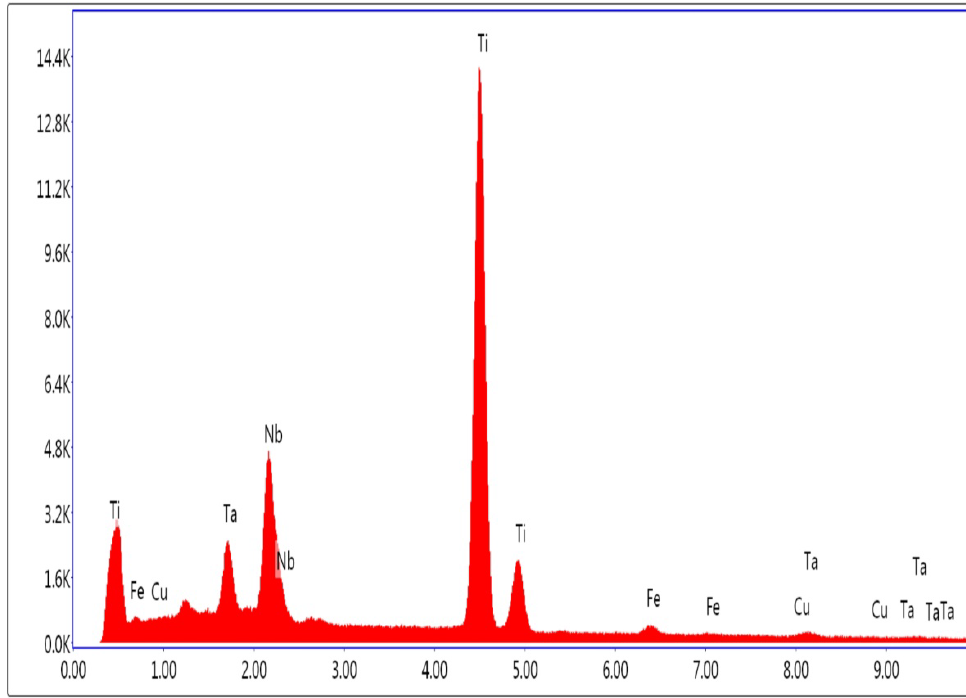
Figure 4. EDX spectrum of the alloy Ti-17Nb-6Ta.